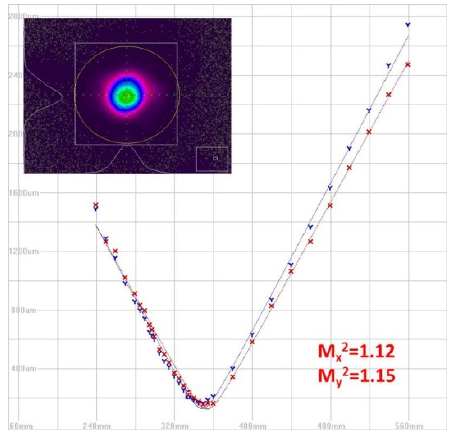
Figure 5. Pulse building process in the regenerative amplifier.